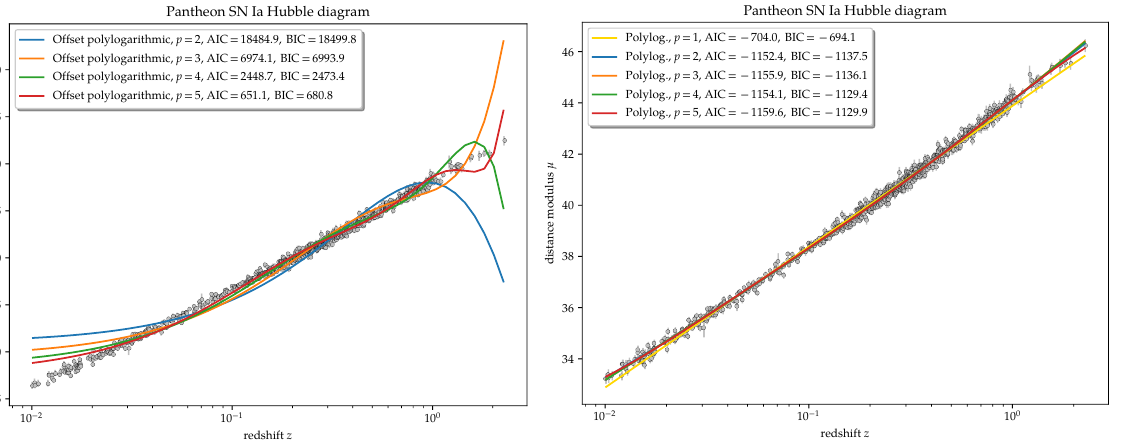
Figure 2. The result of fitting the shifted polylogarithmic function ( left ) and polylogarithmic function ( right ) to the Pantheon SNe Ia